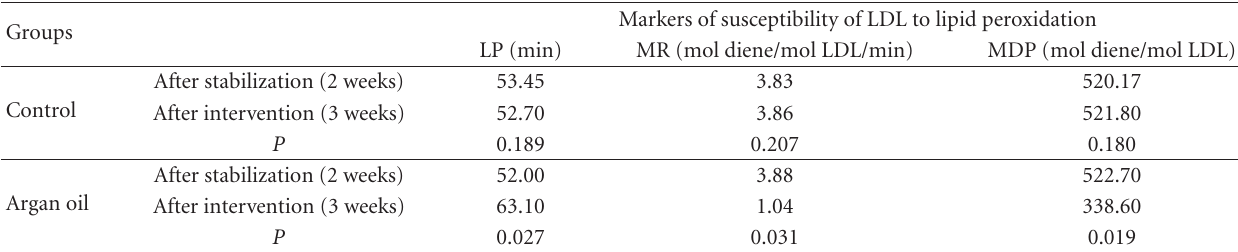
Markers of susceptibility of LDL to lipid